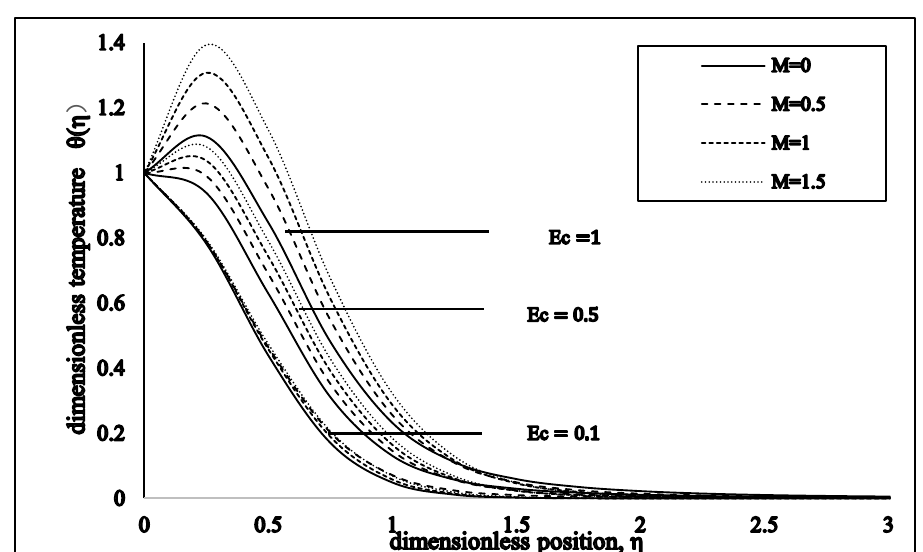
Figure 4. Impact of 𝑀 and 𝐸𝑐 when 𝑃𝑟 = 𝐿𝑒 = 10, 𝑁𝑏 = 0.2 and 𝑁𝑡 = 0.1 on Temperature